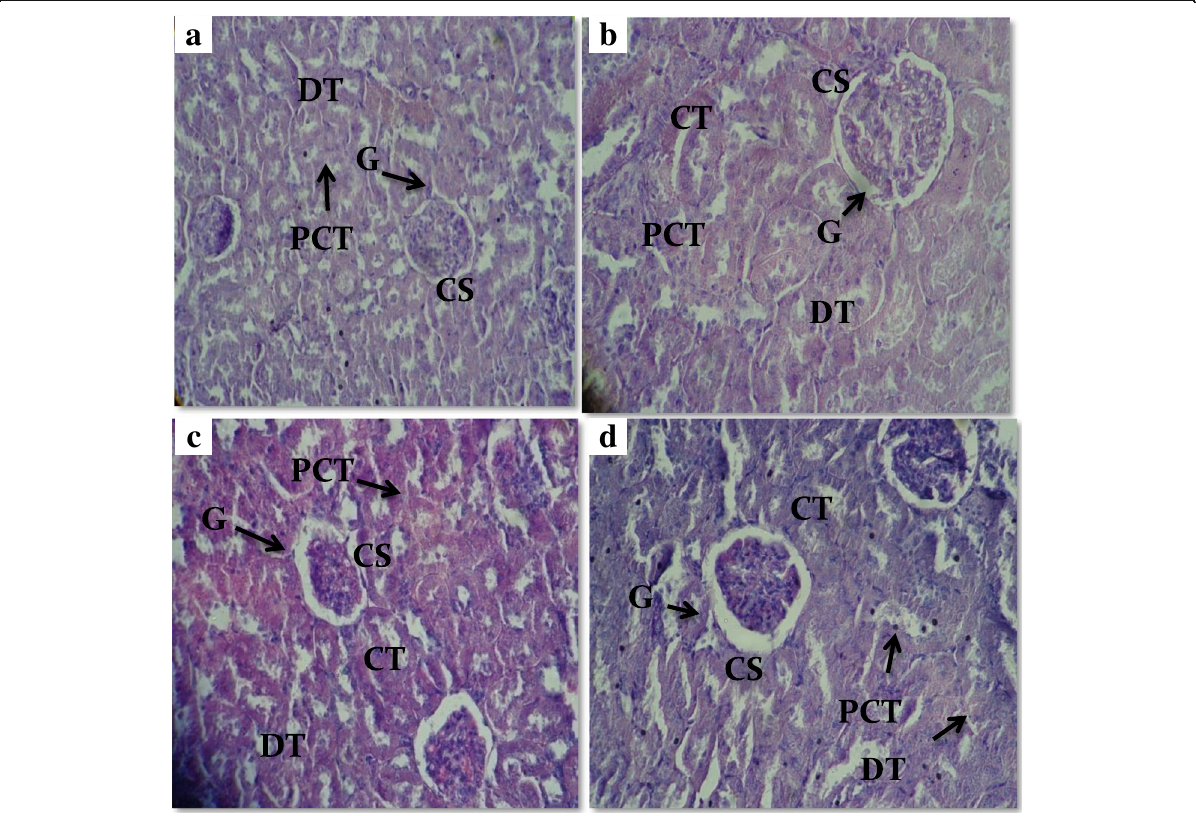
Fig. 2 Kidney histological sections of rats in sub-acute toxicity study. a Normal control group; b 10 mg/kg BA-treated group; c 10 mg/kg UA- treated group; d 50 mg/kg APAP-treated group (× 40, H&E stained). G — glomeruli, DT — distal tubules, CS — capsular space, CT — collecting